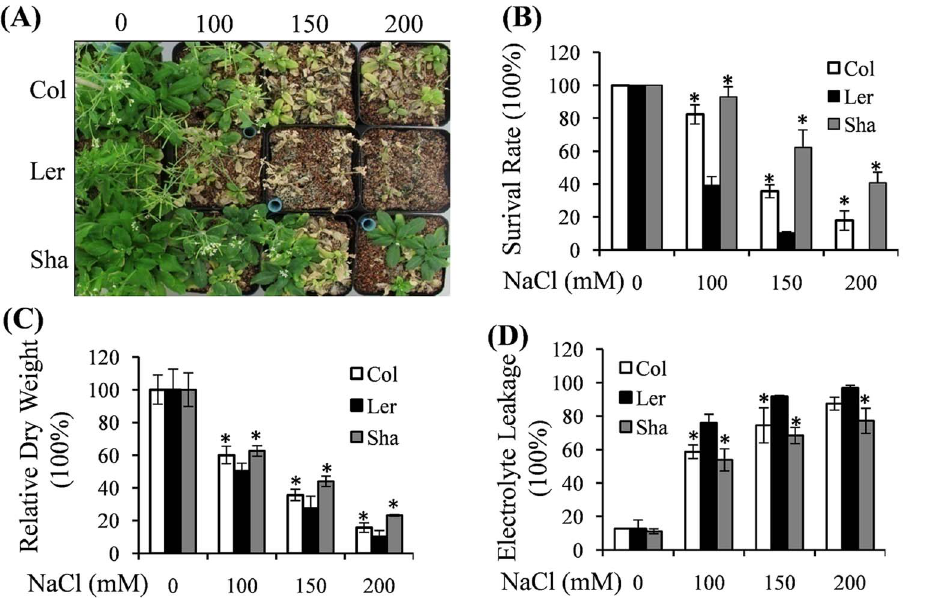
Figure 2. Adult phenotypes analysis among Col, Ler and Sha after salt stress treatment. Salt treatments were initiated at 14 DAS (Day-After-Sowing). (A) 2-week-old seedlings of Col, Ler and Sha were treated with indicated concentrations of NaCl for 14 days. Plants were photographed after 2 weeks treatments. (B) Survival rates were calculated from the results of above three independent experiments (n=20). The values indicated means + SEs. * indicated significant difference with P , 0.05 ( t-test ) in relative to Ler. (C) Relative dry weight comparison after salt treatment. The values indicated means + SEs of four independent experimental repeats (n=30). * indicated significant difference with P , 0.05 ( t-test ) in relative to Ler. (D) Plants were grown for 2 weeks under normal condition and exposed to different concentrations of NaCl treatments. At 10 days after treatment, aerial plants were harvested for measurement of relative electrolyte leakage. The values indicated means + SEs of four independent experimental repeats (n=15). * indicated significant difference with P , 0.05 ( t-test ) in relative to Ler.